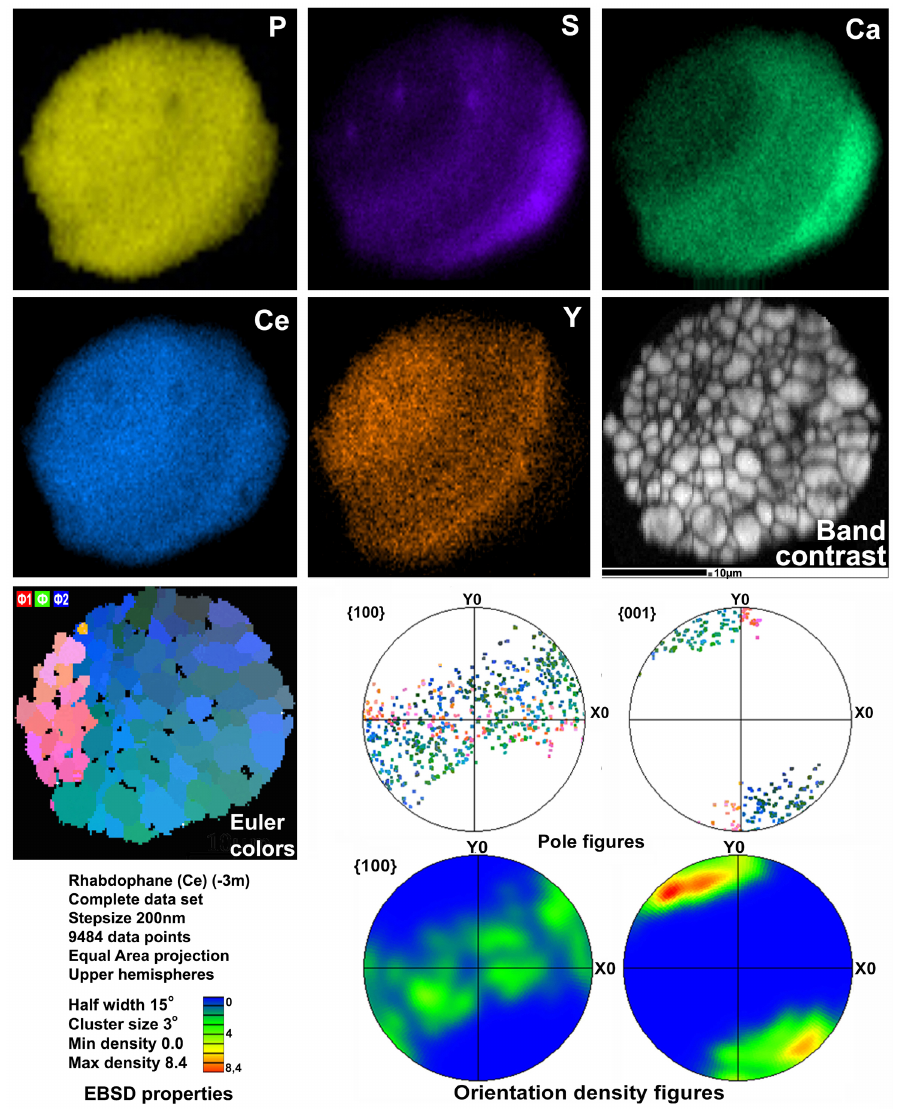
Figure 7. Distribution of elements, EBSD band contrast, rhabdophane crystal orientation in Euler colors, pole figures (each point in the pole figures corresponds to one point in the rhabdophane crystal orientation map and retains its color) and orientation distribution density heatmaps of spherical rhabdophane aggregate; for BSE image, see Fig.